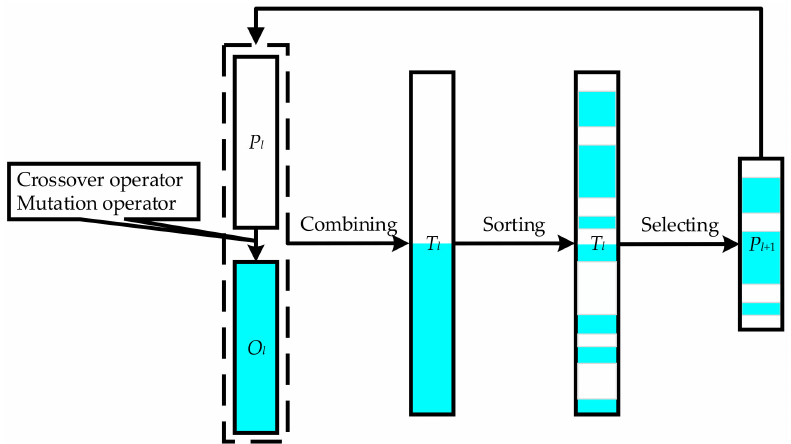
Figure 11. Tournament selection operator with the parent-offspring competition